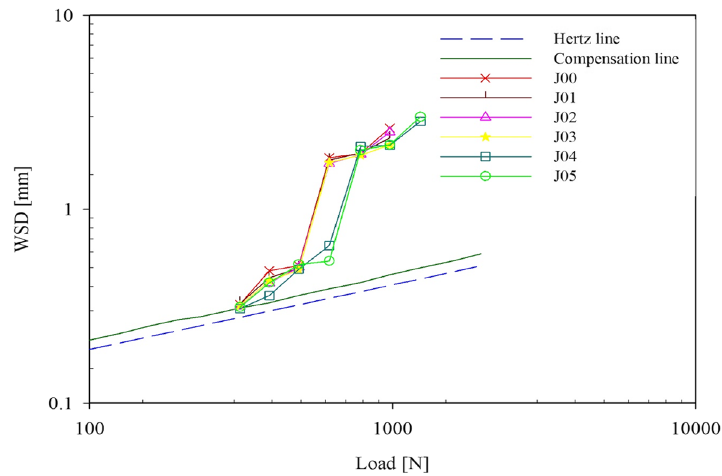
Fig. 9 Wear scar diameter vs. load curve for various concentrations of CaCO 3 NPs in jojoba oil